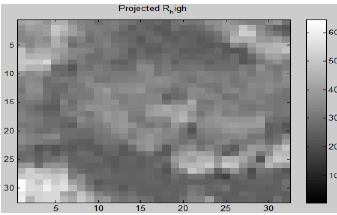
Figure 11a. Projected 32 × 32 pixels for red channel